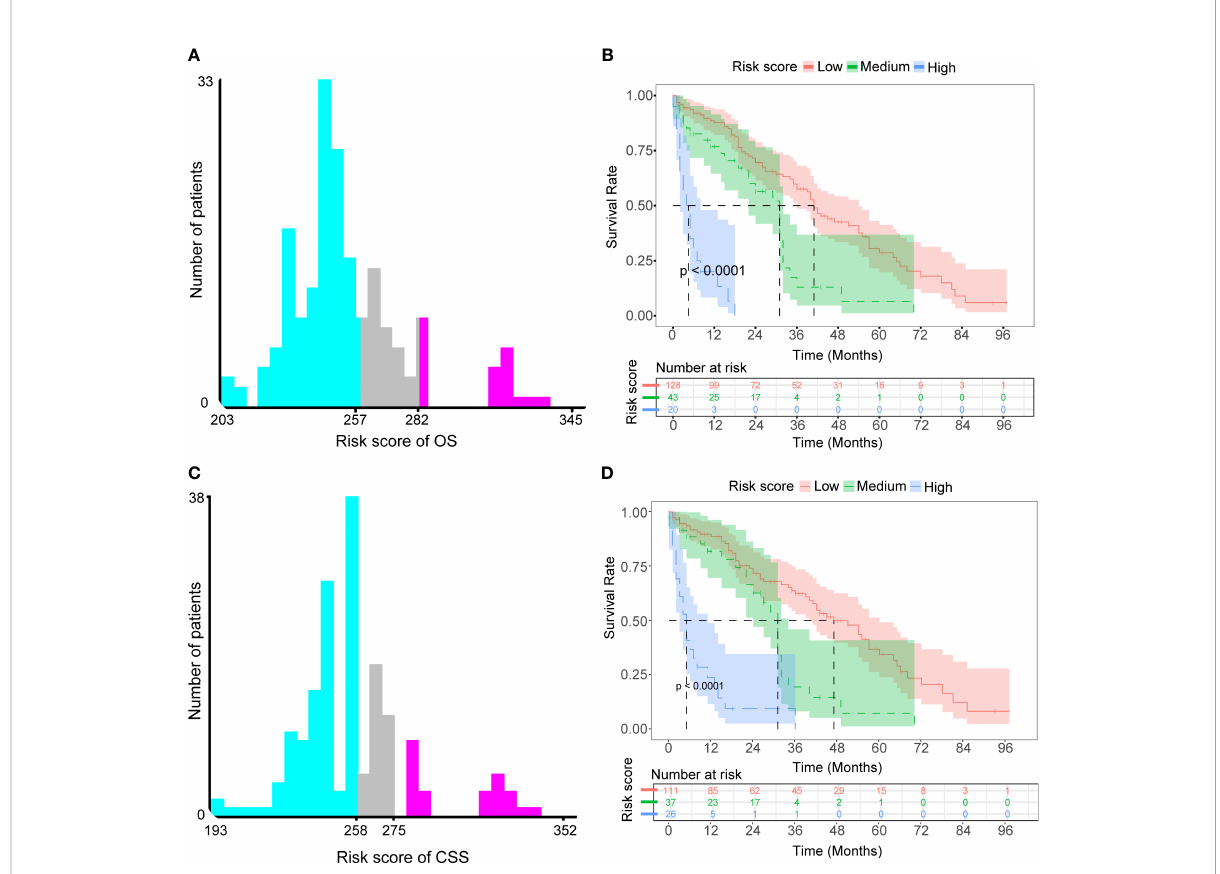
FIGURE 7 Determined optimal cutoff points for risk scores to construct two risk strati fi cation systems for OS and CSS. (A) X-tile software identi fi ed the optimal cutoff point for risk scores for OS by the histogram. (B) Kaplan-Meier survival analysis plotted prognostic curves among distinct risk groups for OS. (C) X-tile software identi fi ed the optimal cutoff point for risk scores for CSS by the histogram. (D) Kaplan-Meier survival analysis plotted prognostic curves among distinct risk groups for